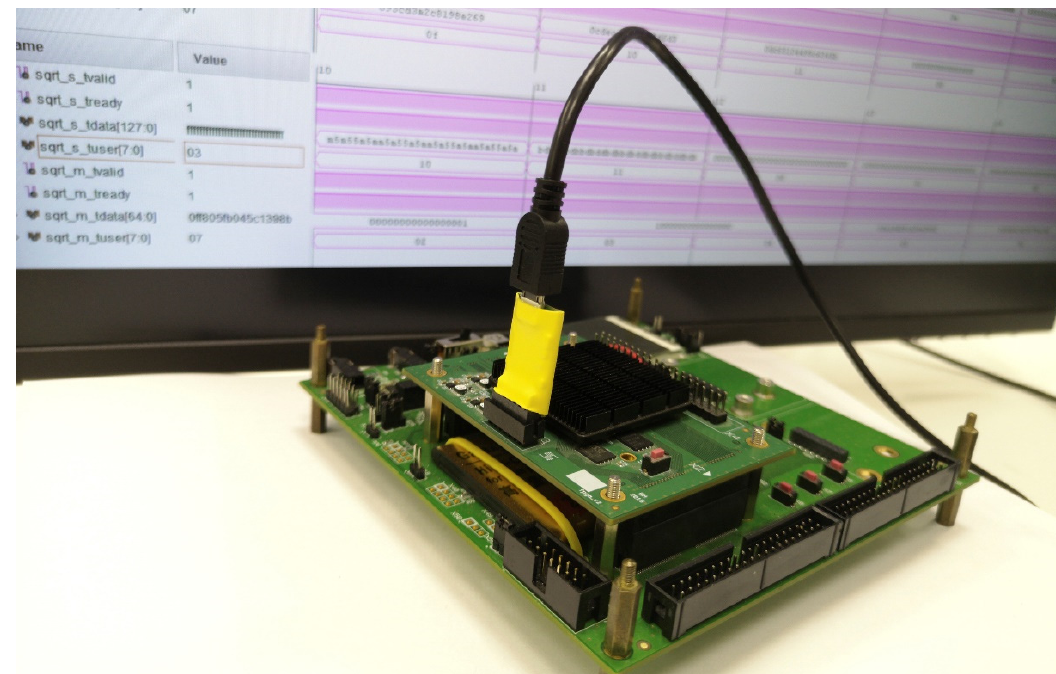
Figure 3. An experimental setup for the field testing.